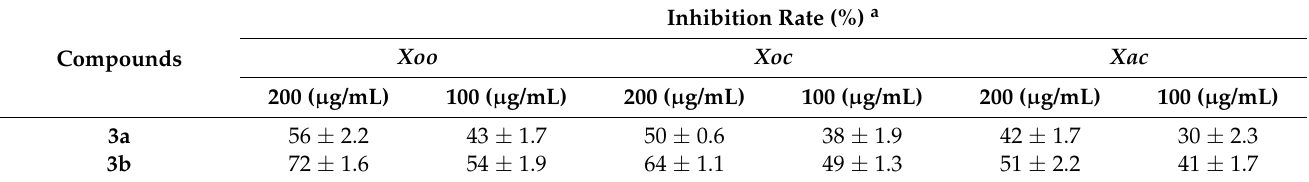
Table 1. In vitro antibacterial activities of the target compounds 3a – 3h and 4a – 4x against Xoo , Xoc , and Xac at 200 and 100 µ